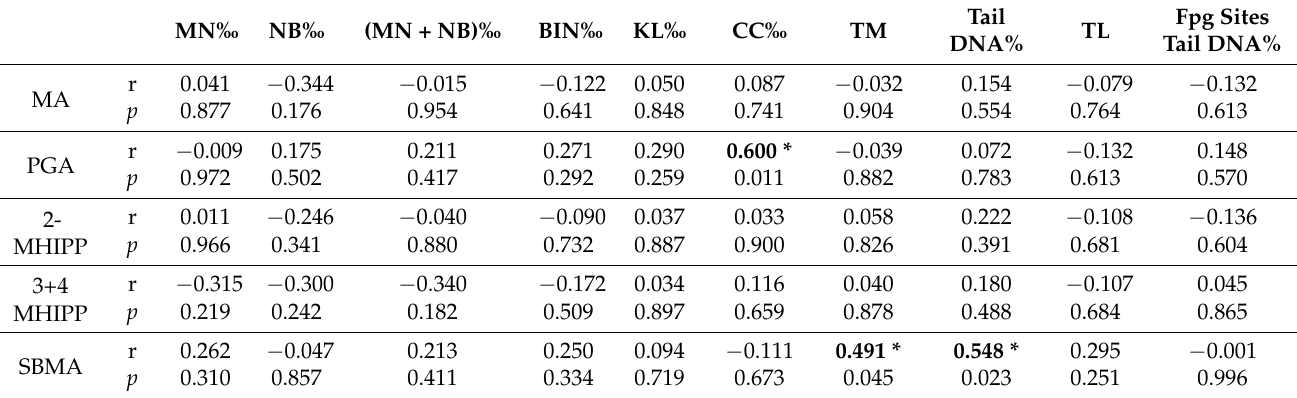
Table 4. Pearson’s correlation analysis between biomarkers of exposure and biomarkers of effect evaluated, taking into account all the exposed